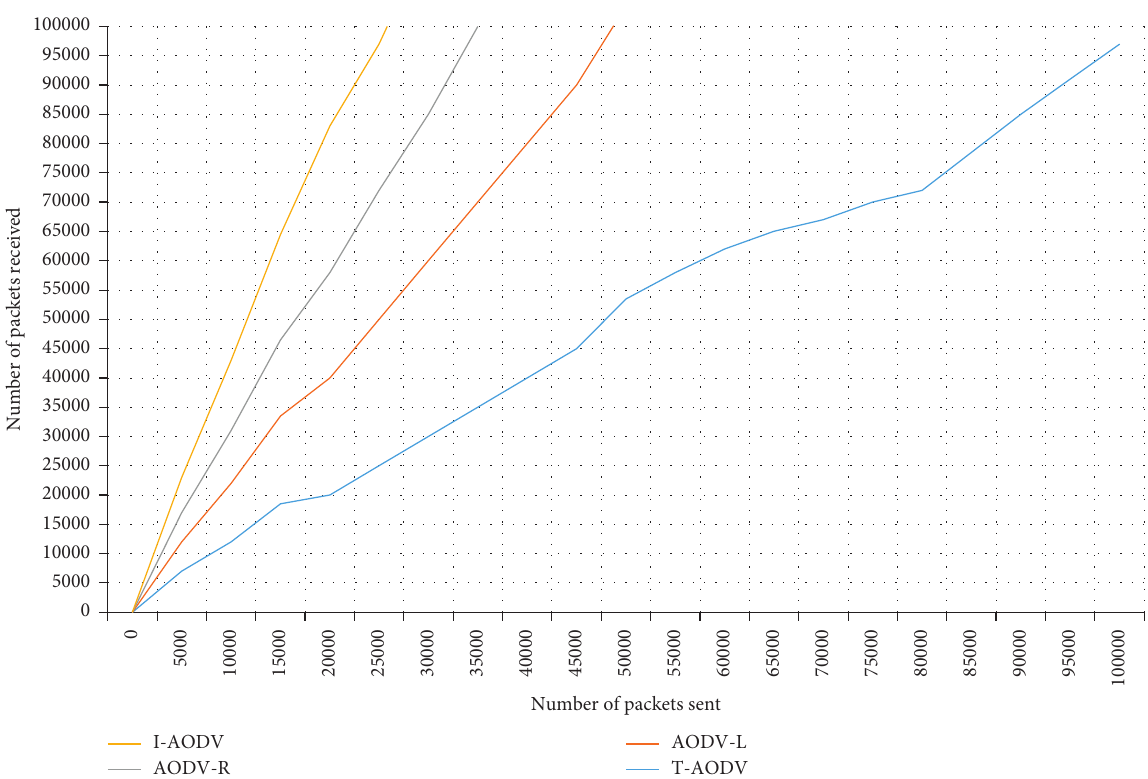
Figure 6: Packet delivery ratio of the